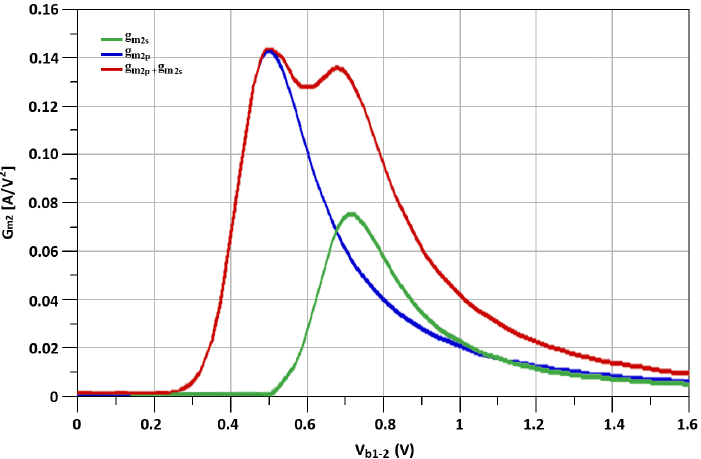
Figure 12. The simulated g m1s , g m1p and g m1s + g m1p of M p and M s transistors.